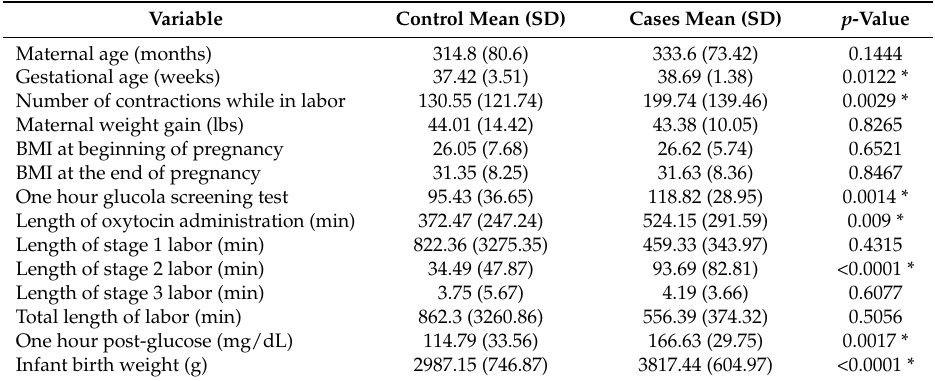
Table 1. Characteristics of maternal and infant factors for controls and cases.